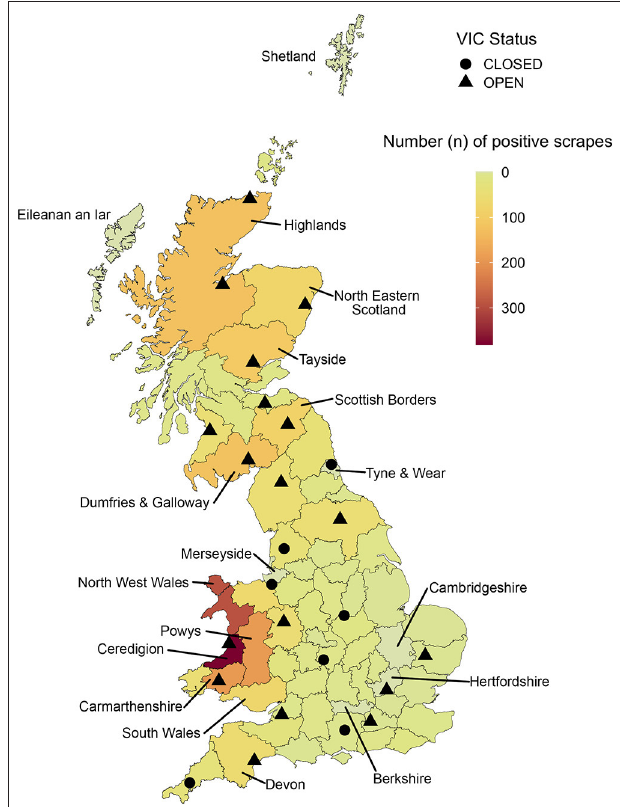
FIGURE 3 | Spatial distribution of the total VIDA positive scrapes (sheep scab diagnoses) from 2003-2018. Points overlaying this represent the DSCs and VICs that were open during the study period. The shape of the point, a circle of triangle, represents the centre’s status as of 2020: closed or open, respectively. Labels identify the names of key regions mentioned in text and Table 1 .